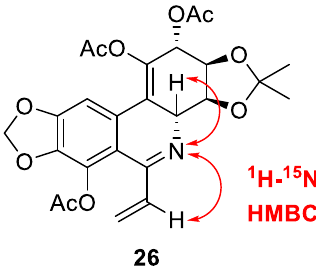
5 of 18 Figure 2. Suggested mechanism for the formation of C-1 enol. 2.2. Synthesis of Cross-Coupling Substrates With the enols 12ab , 17ab in hand, we set out to prepare the C-1 triflate and subjected the resulting compounds to cross-coupling. However, early trials resulted in sluggish reac- tions with low yields of the desired vinyl triflate. It was believed that such results were ob-